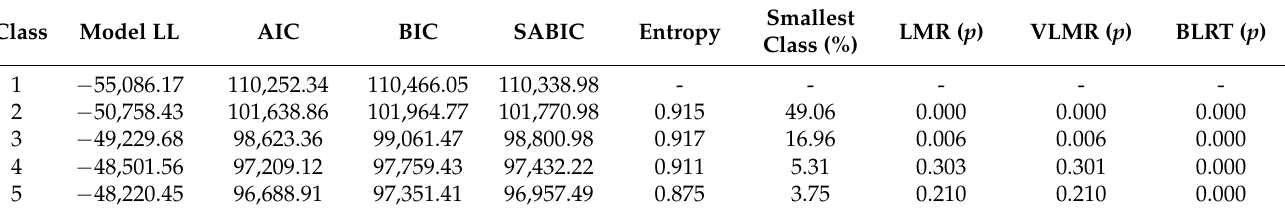
Table 2. Determination of class number for Group 2–20 items.